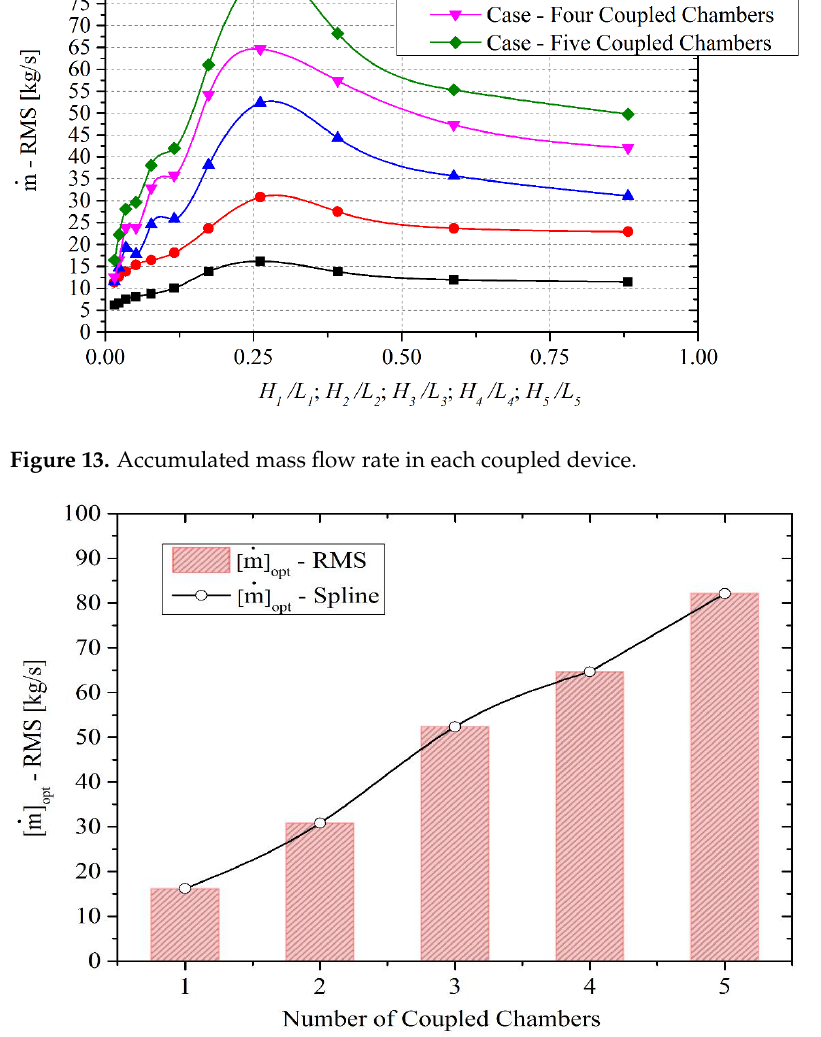
Figure 15. Accumulated available hydropneumatic power in each coupled device. As in the other analyzed quantities, the available hydropneumatic power presents its highest values in each of the configurations studied in the range of 0.25 < Hn/Ln < 0.50.